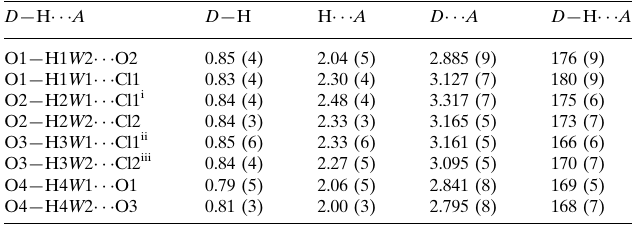
Hydrogen-bond geometry (A˚ , (cid:4)